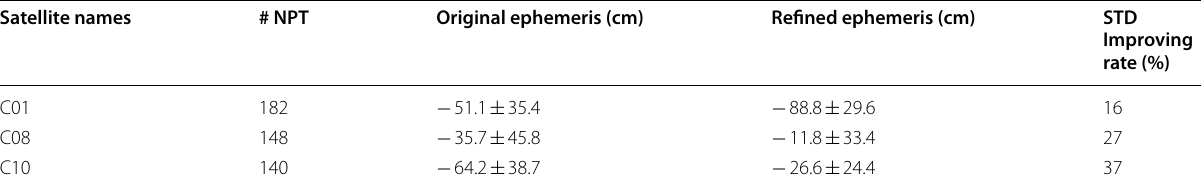
Table 1 Orbits quality validation of BDS satellites C01 (GEO), C08 (IGSO), and C10 (IGSO) using SLR observations, showing the offsets, STD for the original BDS broadcast ephemeris and refined broadcast ephemeris